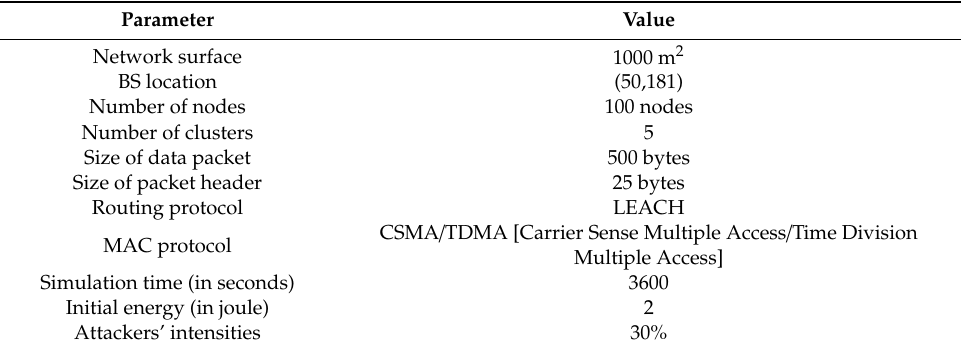
Table 6. Simulation parameters.